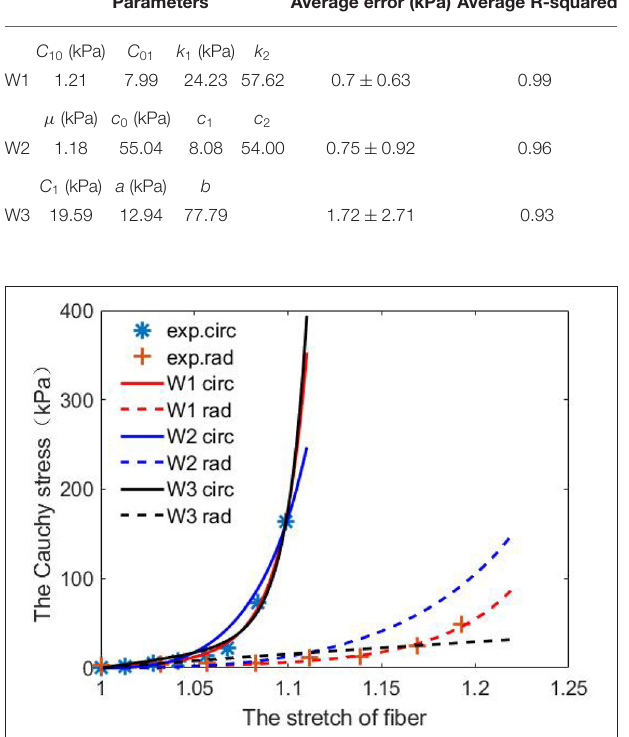
FIGURE 5 | Predictions from the fitted three constitutive laws [Equations(10)–(12)] using one set of porcine experimental data.